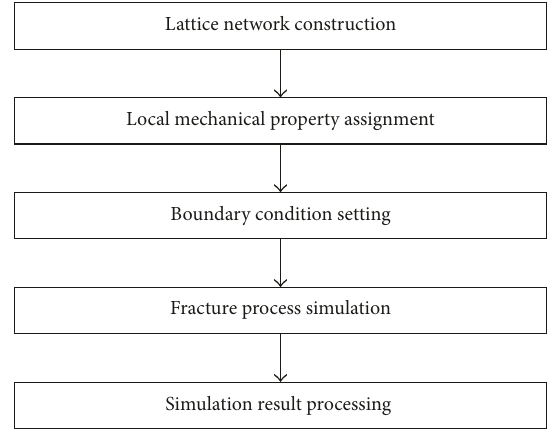
Figure 1: Procedures of lattice fracture simulation.